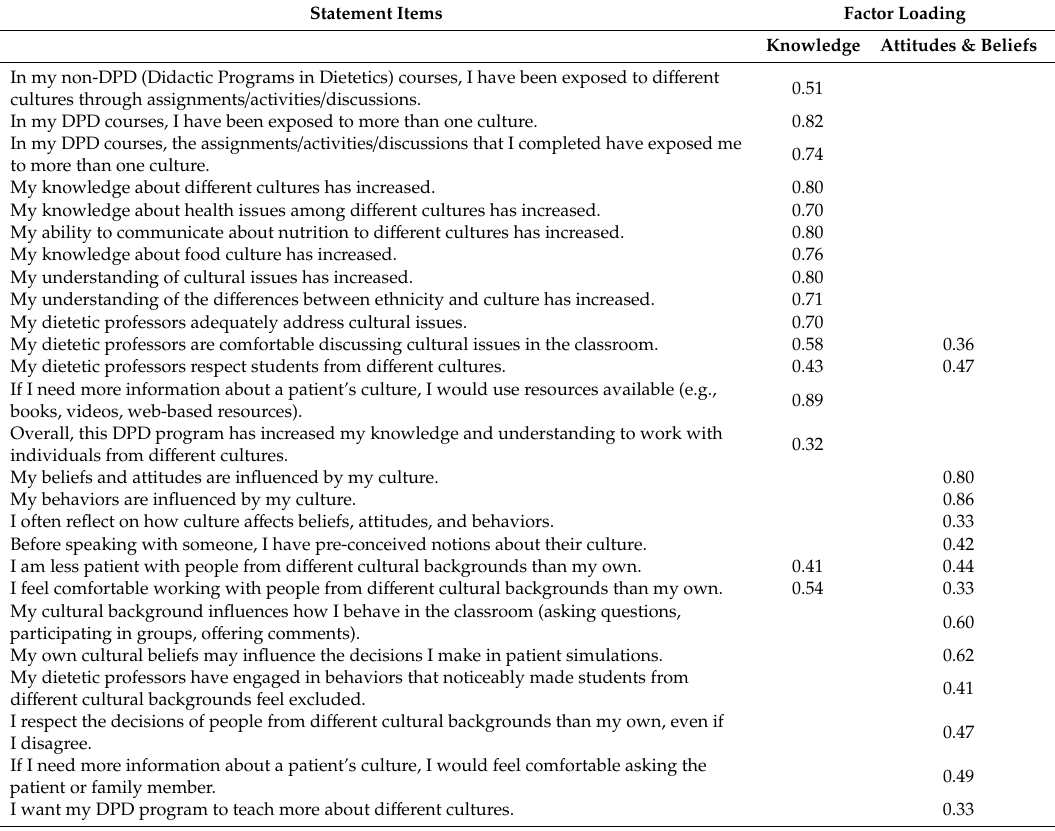
Table 4. Factor loadings of general knowledge, attitudes, and beliefs (KAB)